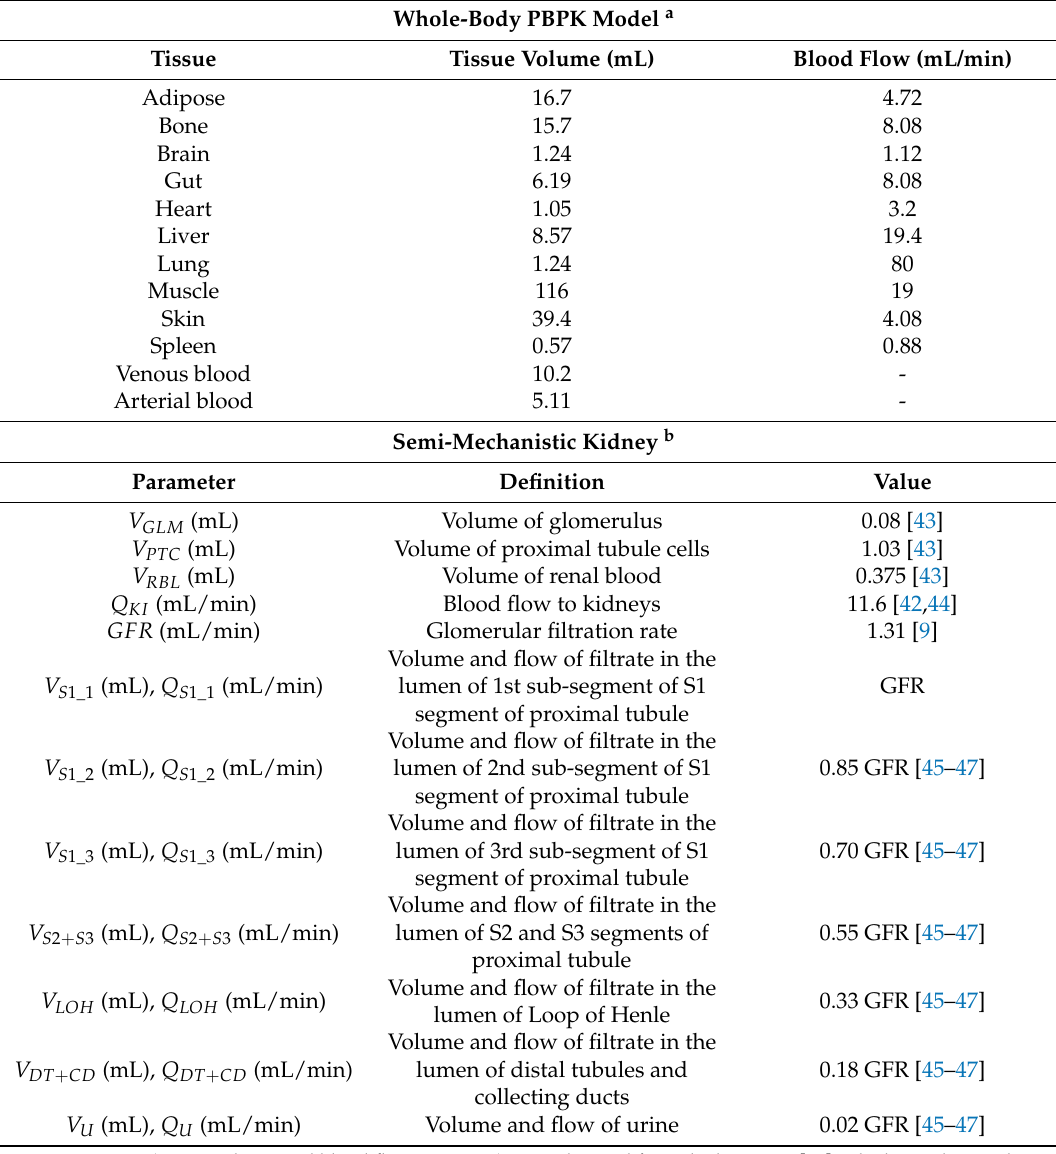
Table 1. Summary of physiological and anatomical variables used for PBPK calculations of PA, NAPA and cimetidine in